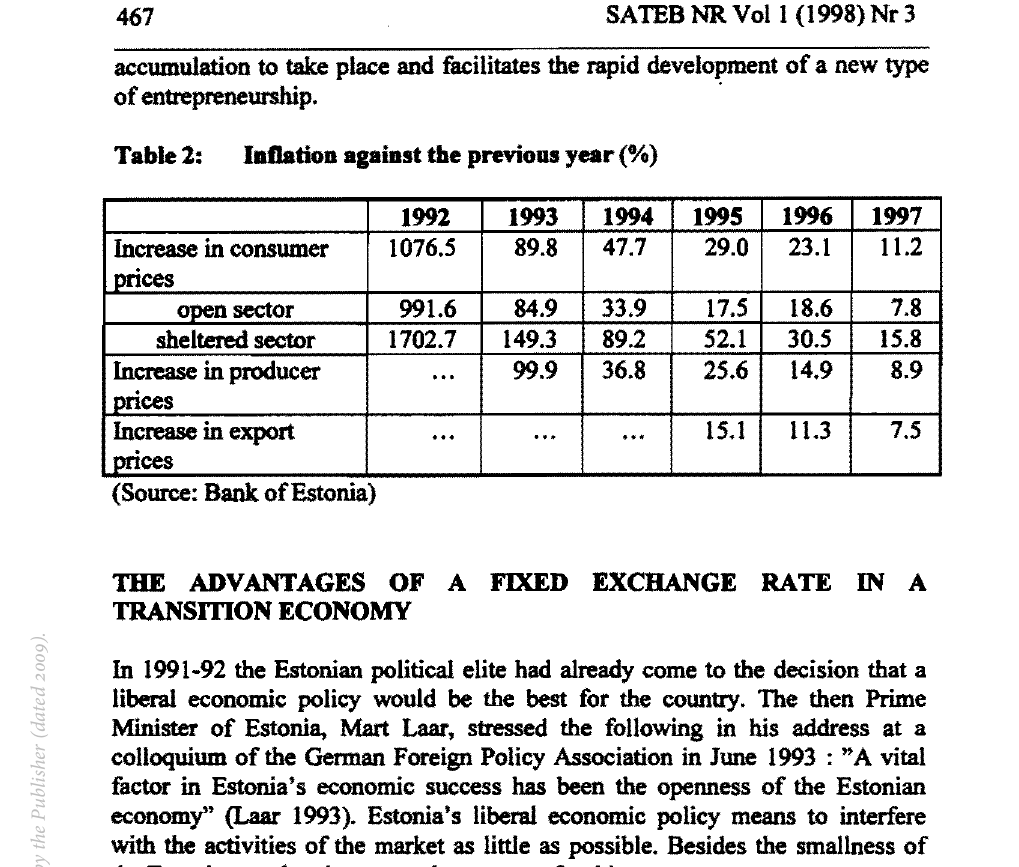
laDation against the previous year